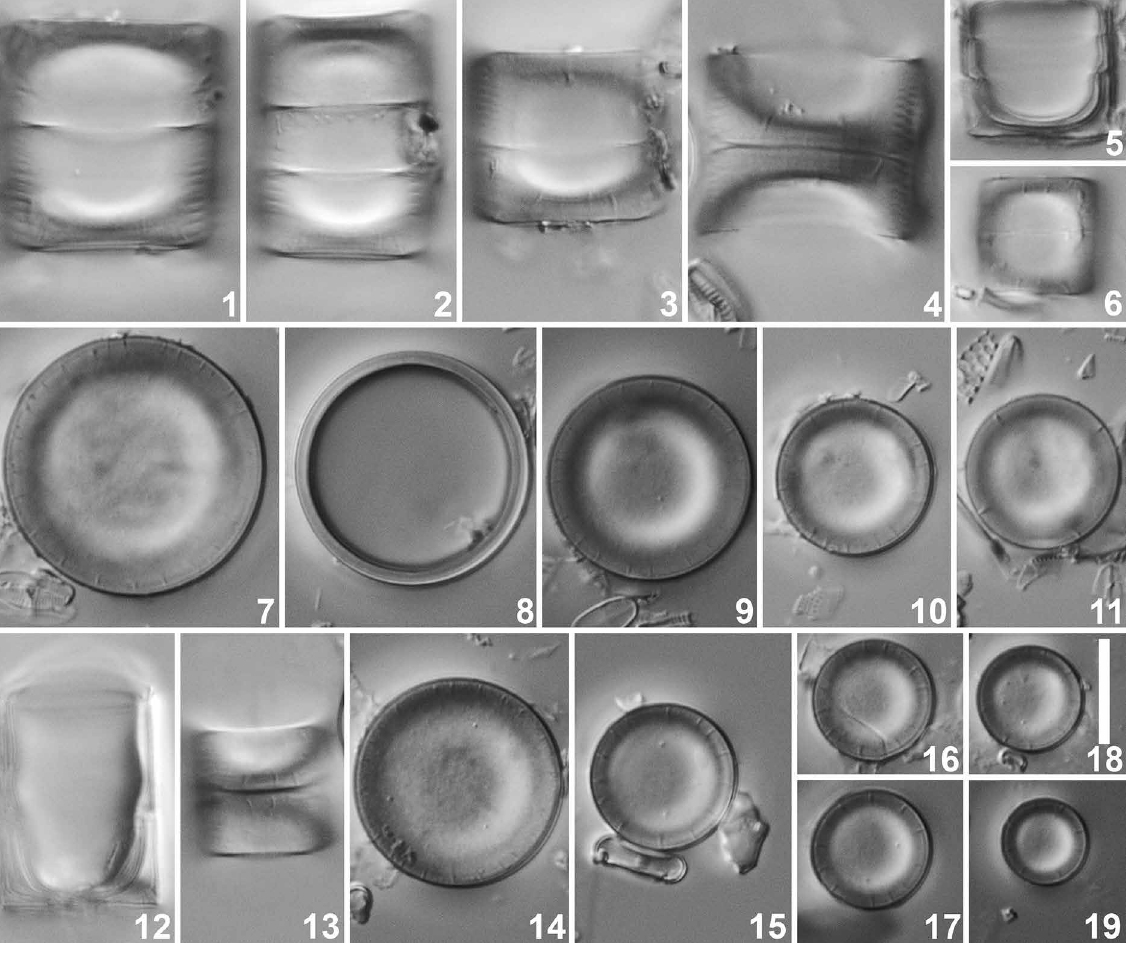
Figs 1–19. Angusticopula chilensis (Grunow) Houk et al. LM. Campbell Island epitype population, sample BAS286. 1–6, 12–13 . Several frustules in girdle view. 5, 12 . Internal valves. 7–11, 14–19 . Several valves in valve face view clearly showing the marginal rimoportulae. Scale bar = 10